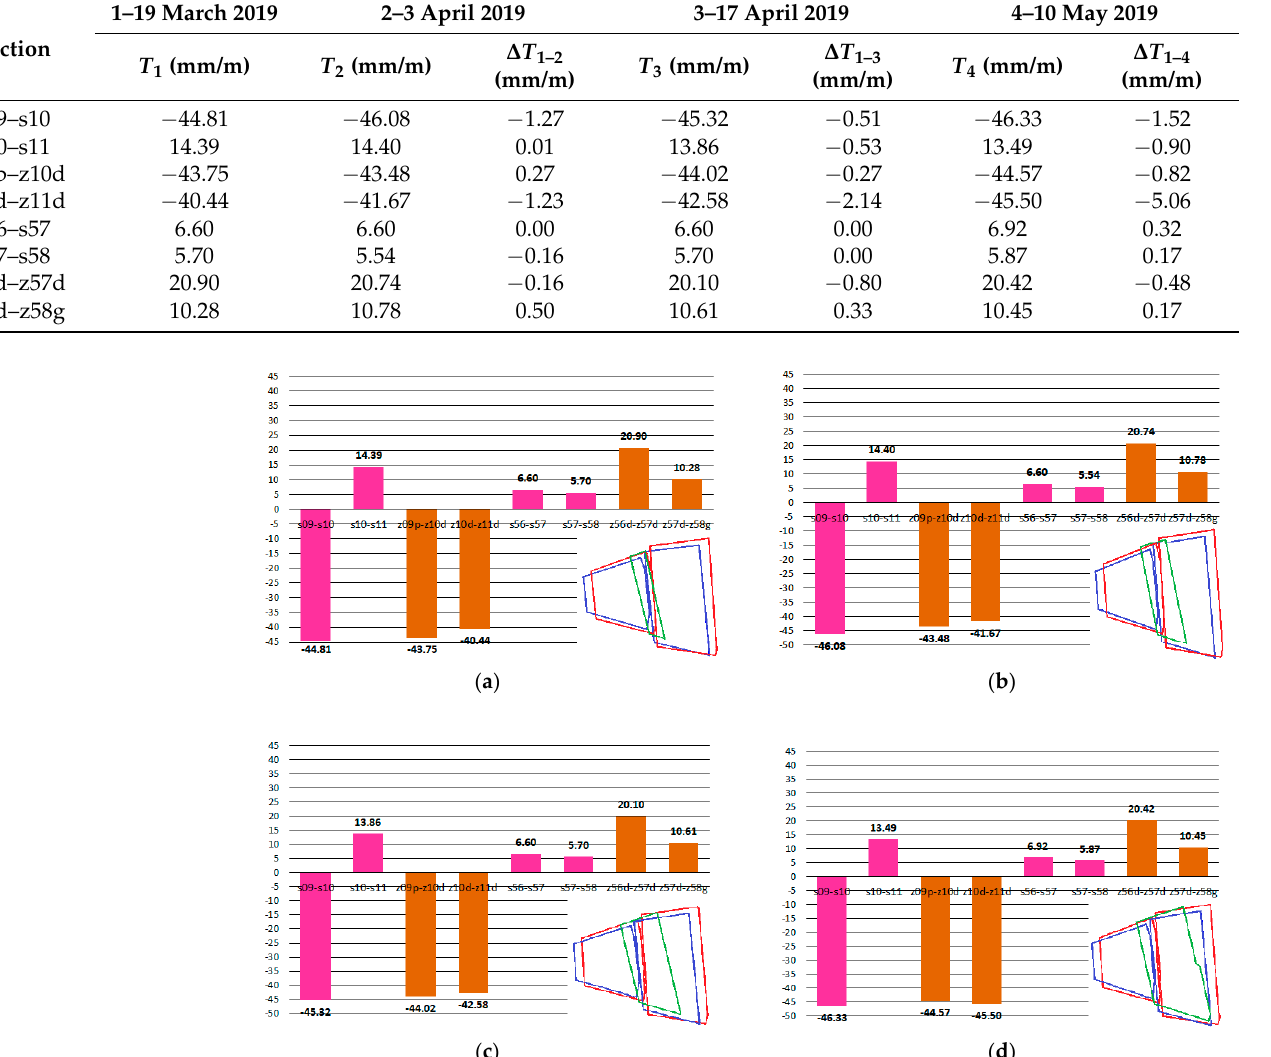
Figure 8. The values of inclinations (vertical axis) observed on the ground sections—brown color and the wall sections—pink color (horizontal axis) in the time period of March–May 2019, and the progress of the 1/II longwall in the 405/1 hard coal seam: ( a ) 19 March 2019; ( b ) 3 April 2019; ( c ) 17